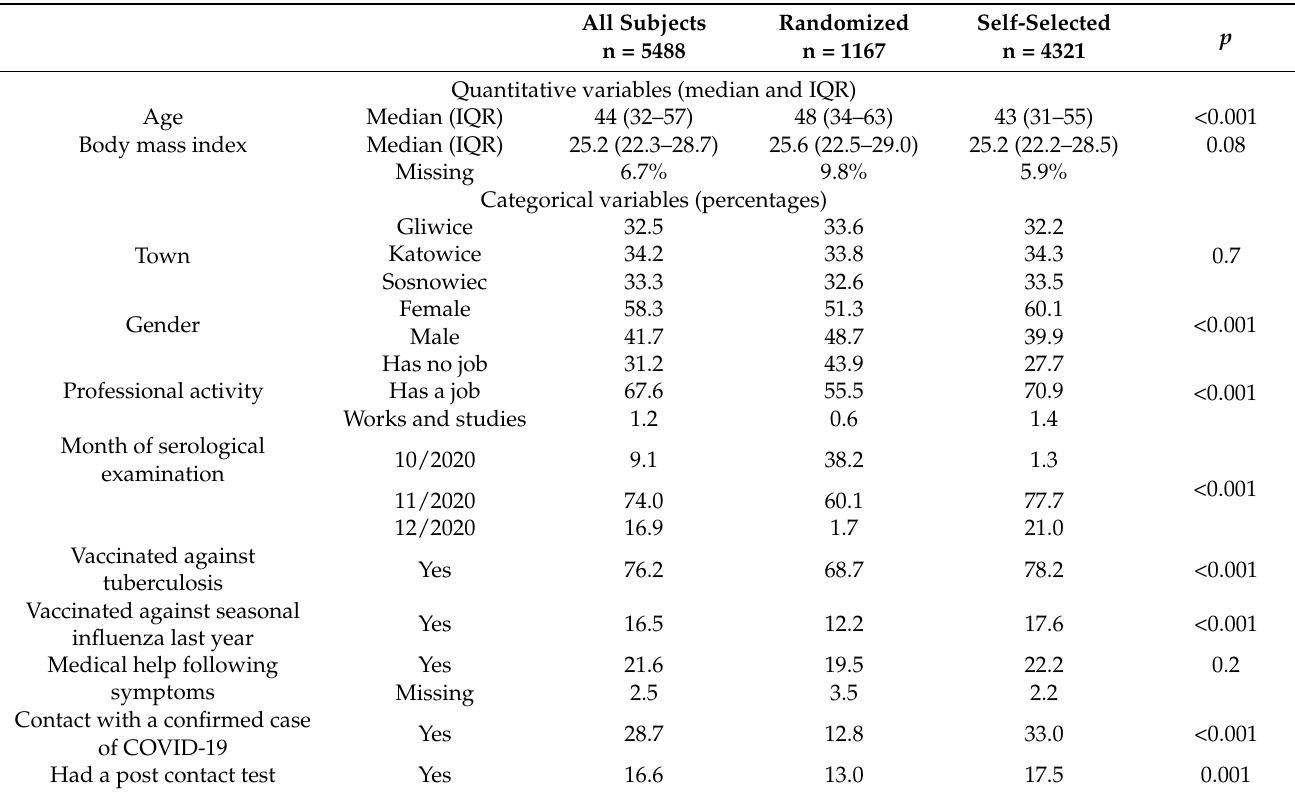
Table 1. Basic sociodemographic characteristics (relative frequencies presented as percentages or median with interquartile ranges.